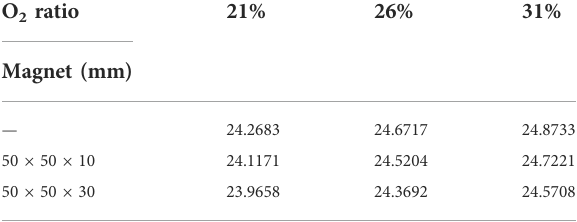
Frontiers in Energy